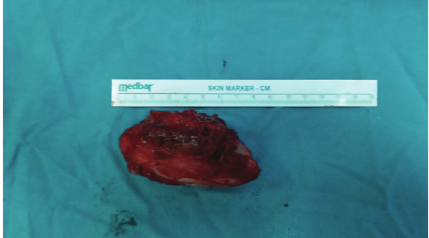
Figure 2: Preoperative radiographic evaluation with 3D and sagittal view of CT.